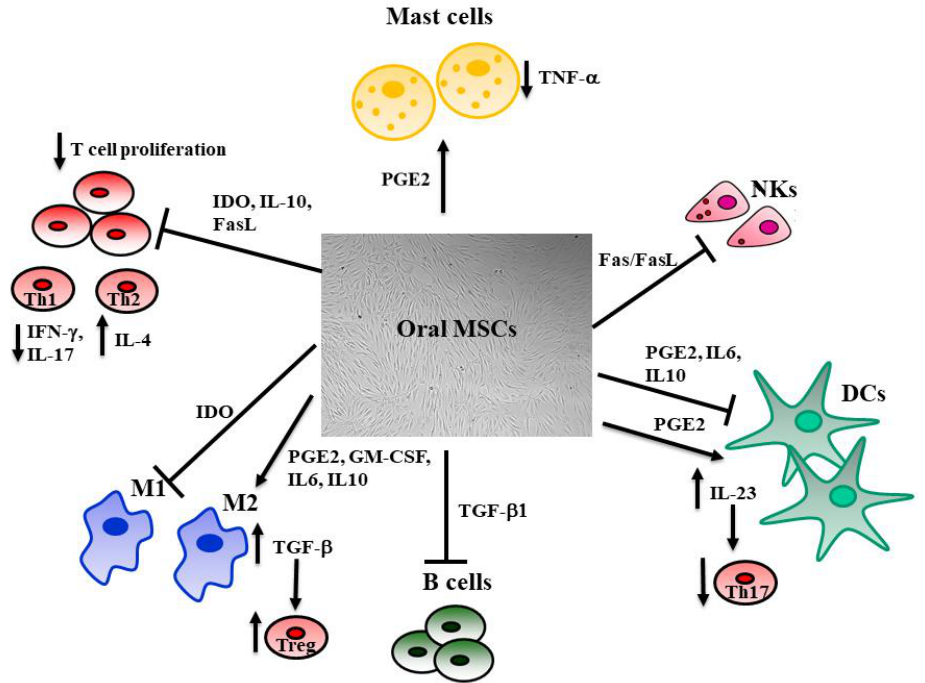
Figure 2. The influence of MSCs on immune system cells. MSCs regulate local inflammation by interacting with innate and adaptive immune system cells. The antigen-presenting cell activity mediated by dendritic cells (DCs) is downregulated by MSCs through the inhibitory effect due to IL- 10, IL-6, and PGE-2. This last also increases the release of IL-23, which stimulates Th17. MSCs inhibit the pro-inflammatory M1 macrophages through the activation of the indoleamine 2,3-dioxygenase (IDO) pathway and promote M2 macrophages, increasing the release of PGE-2, IL-6, IL-10, and GM- CSF. M2 also activates T-regs through the TGF- β pathway. T and natural killer (NK) cell proliferation is inhibited by MSCs’ release of IL-10, IDO, and activation of the Fas/Fas Ligand pathway, resulting in reduced production of IFN γ and IL-17 by T helper 1 (Th1), whereas Th2 enhance their production of IL-4. The release of TGF- β 1 hinders B cell proliferation. MSCs inhibit mast cells’ release of TNF- α through the activation of the PGE-2 axis. This regulation of the immune system exerted by MSCs